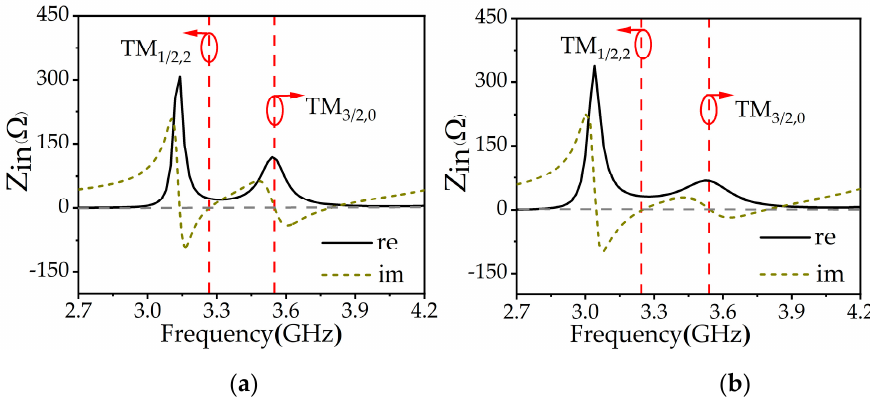
Figure 4. Input impedance of ( a ) PIFA with Slots 1; ( b ) PIFA with Slots 1 and Slots 2.